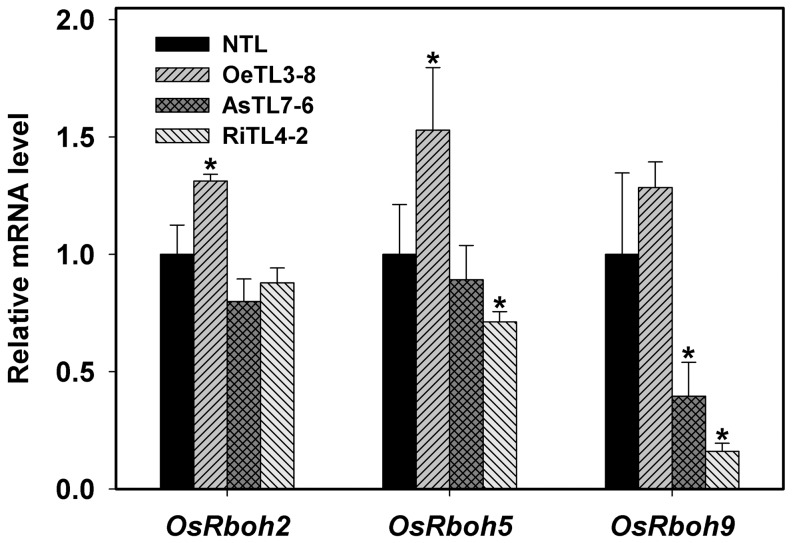
Expressional of OsRbohs in imbibed seeds of the selected transgenic rice lines.Expressions of OsRbohs were monitored in seeds of NTL, OeTL, AsTL and RiTL, respectively after 48 h of imbibition. Relative expression levels were measured by qRT-PCR and normalized with respect to OsActin7 (LOC_Os11g06390). Results shown are means of three biological replications±SE. Asterisks (*) indicate significant difference (P<0.05) between the levels of expression of transgenic lines compared with the NTL.